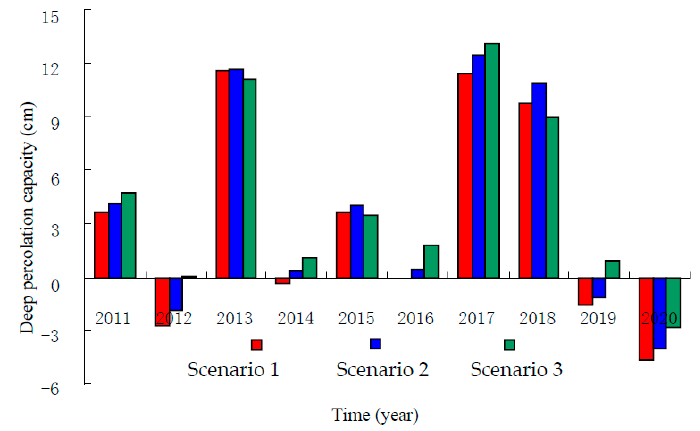
Figure 12. The deep percolation capacity of the root zone (60 cm) of cotton.